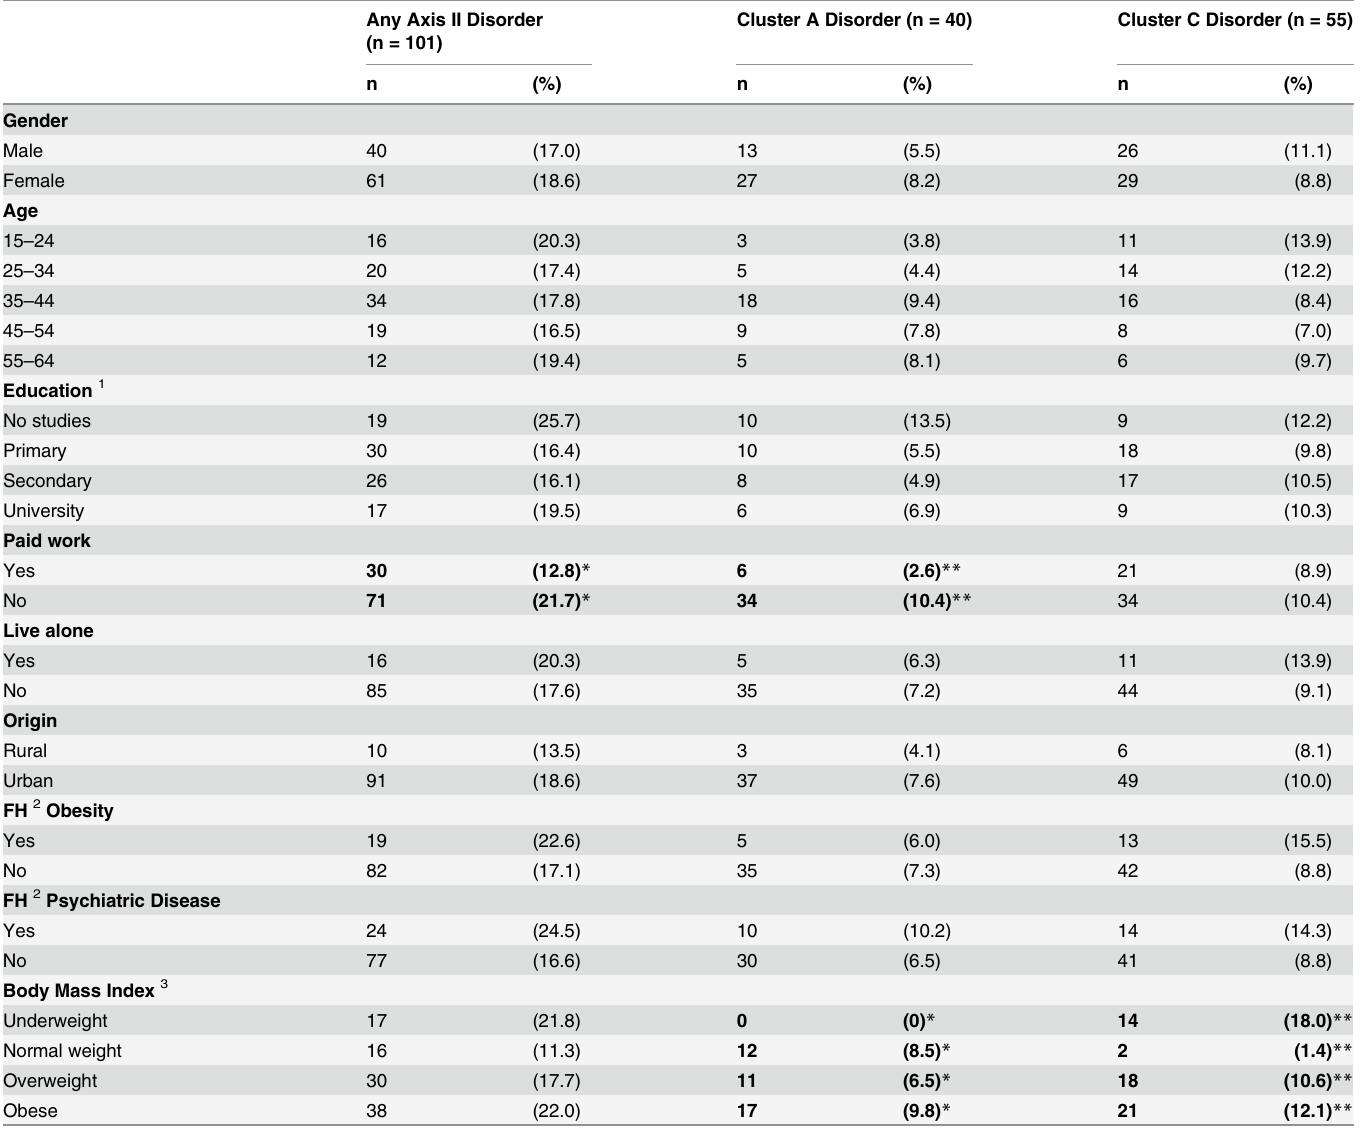
Table 3. Frequency of Axis II disorders by socio-demographic variables and